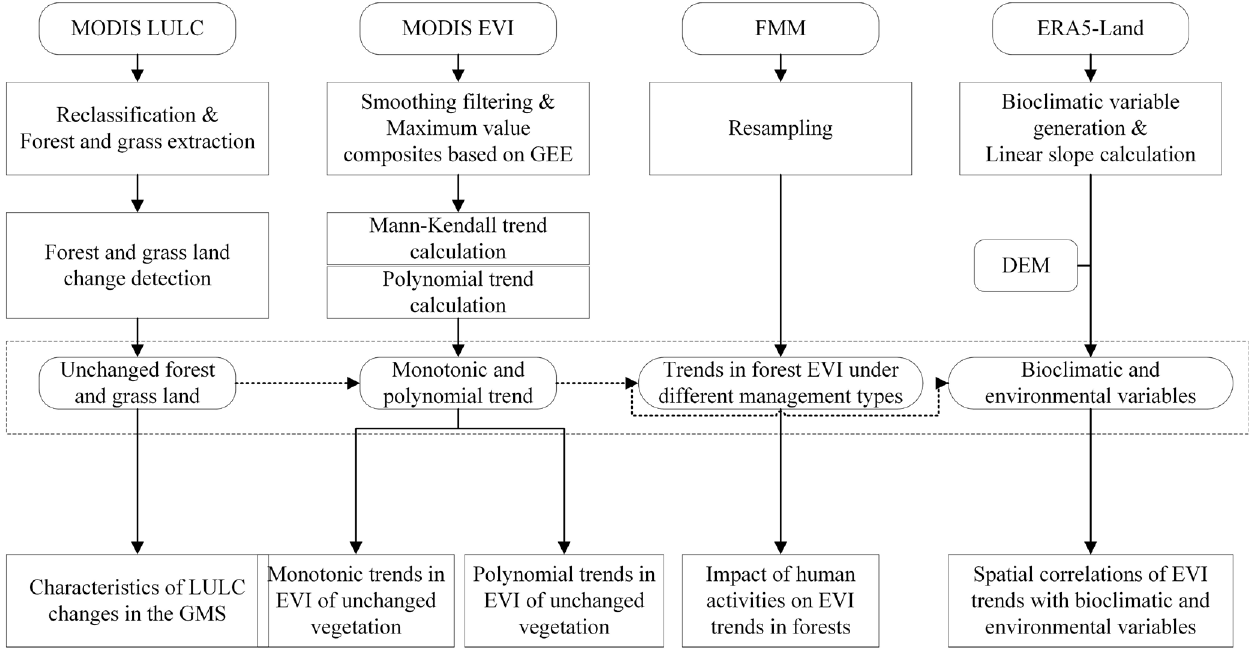
Figure 2. Flow chart of enhanced vegetation index (EVI) trend extraction and spatial correlation analysis.